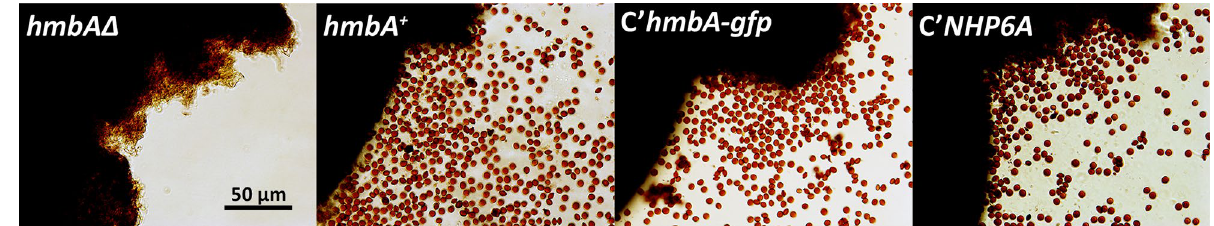
Figure 3. Ascospore content of hmbAΔ , hmbA + control and various complemented hmbAΔ strains. Images show crushed cleistothecia releasing red ascospores. Cleistothecia were collected from self-fertilized 14 days old colonies grown on complete medium. Scale bar is shown. The strains used in the analysis were hmbAΔ ( hmbA deletion strain, HZS.320), hmbA + as control (HZS.120); C’ hmbA-gfp ( hmbAΔ complemented with hmbA-gfp ,